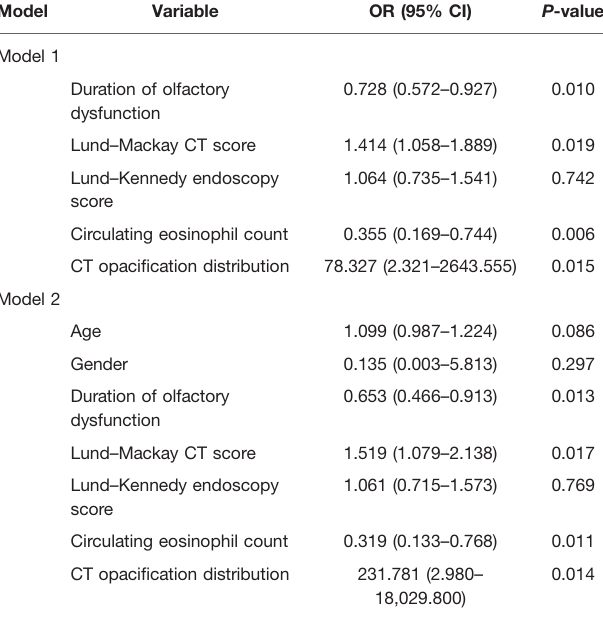
TABLE 3 | Multivariate logistic regression analysis on postoperative olfactory